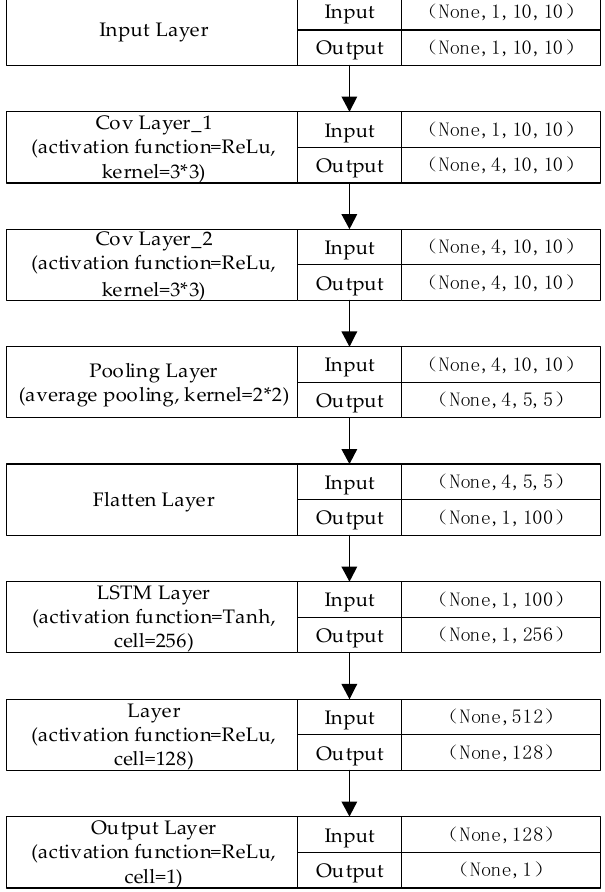
Figure A5. LSTM model architecture.